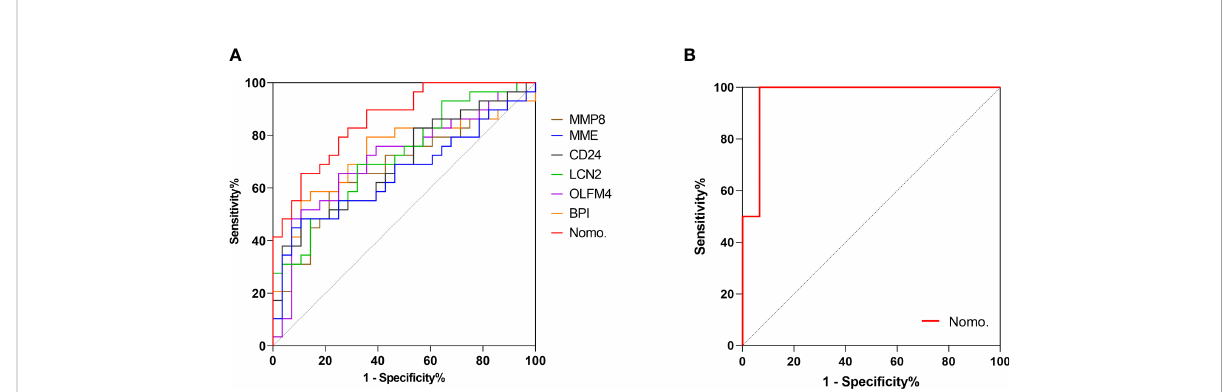
FIGURE 6 Validating the predictive value of the nomogram. Receiver operating characteristic (ROC) curve was adopted to verify the discriminatory capacity of the nomogram and sole use of each DEG in predicting ARDS incidence in septic patients. (A) ROC curve of the nomogram and each DEG in predicting ARDS occurrence among all septic patients. (B) ROC curve of the nomogram for ARDS prediction in septic patients without direct lung